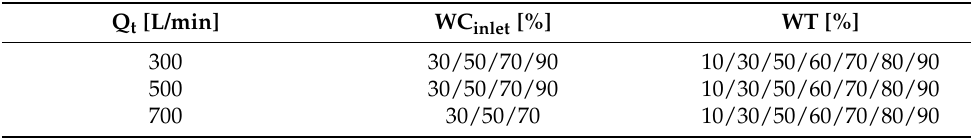
Table 1. Unspiked Exxsol D60 Experimental campaign test matrix.